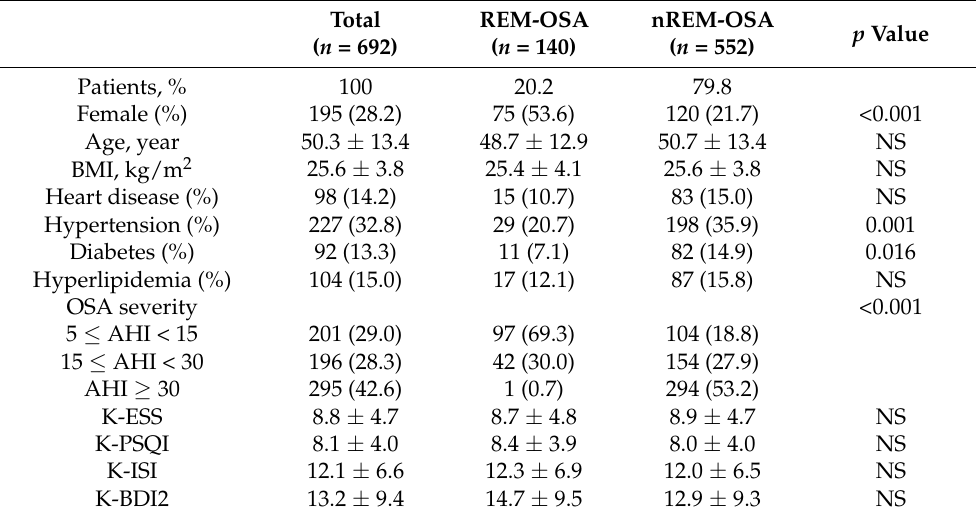
Table 1. The demographic and clinical characteristics of the entire group and REM-OSA and nREM- OSA patients.